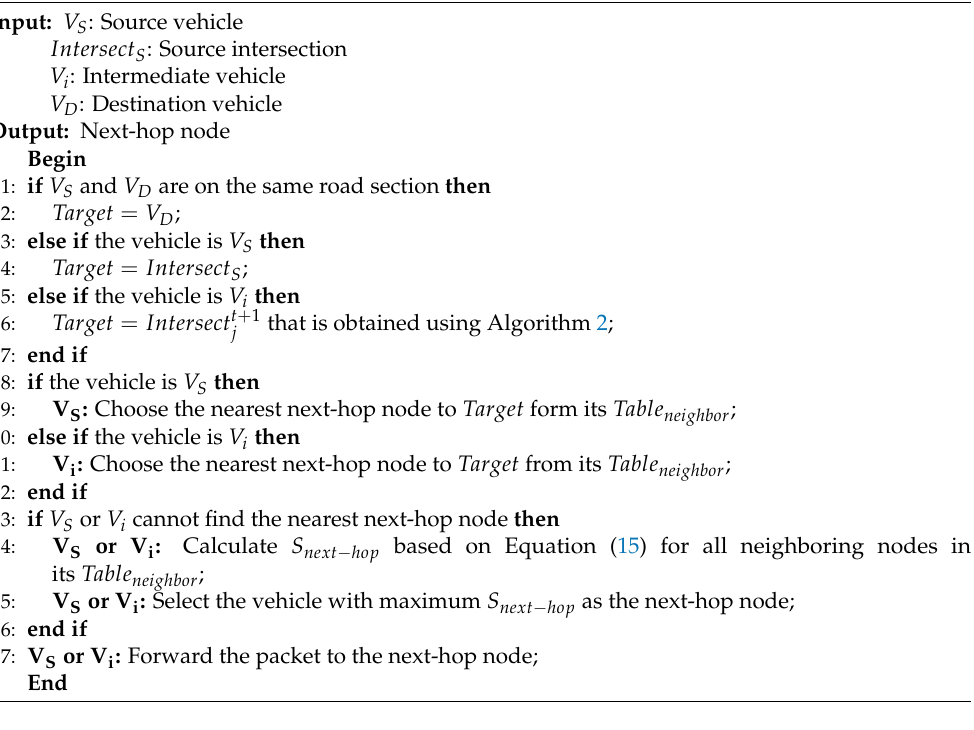
Algorithm 3 Local view based-routing process